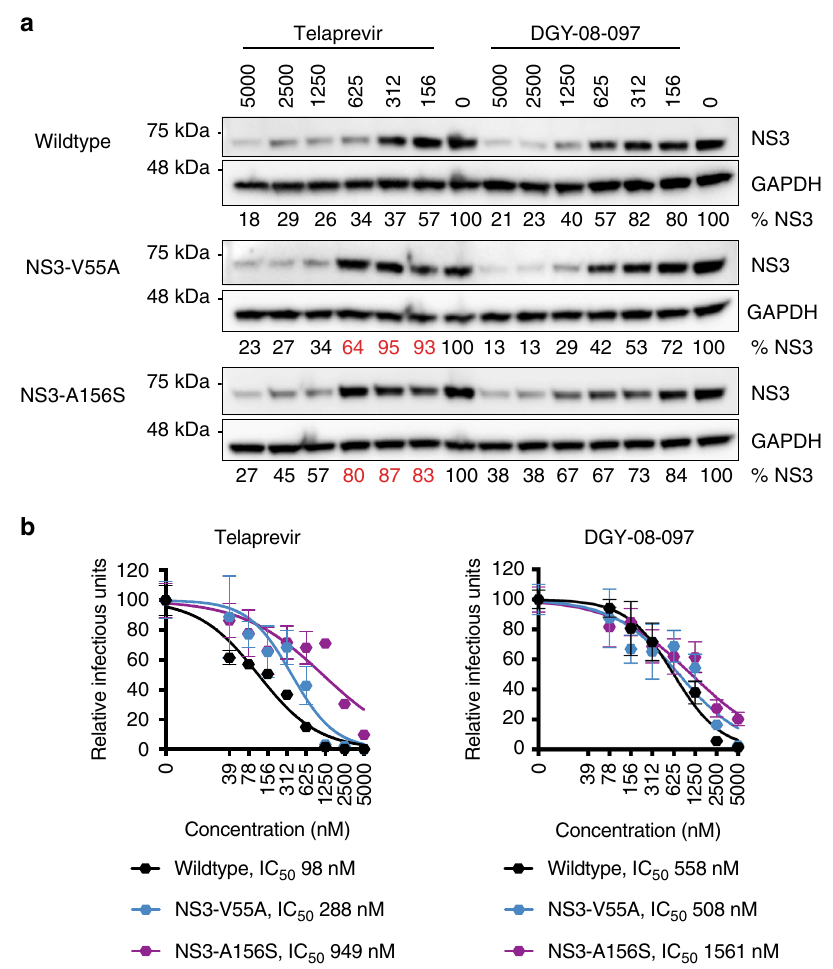
Fig. 4 The NS3 degraders inhibit telaprevir-resistant HCV. Huh7.5 cells were infected with wildtype HCV-Jc1 or the indicated telaprevir-resistant viruses at a MOI of 0.1. The infected cells were treated from 24 to 48 h post-infection with a range of small molecule concentrations (indicated in nM). a HCV NS3 and GAPDH abundance was evaluated by Western blot. Source data are provided as a Source Data fi le. One representative experiment is shown from n = 4. NS3 abundance was normalized to the loading control (GAPDH) and is presented as a percentage of the DMSO-treated control samples. Values represent the means of n = 4 independent experiments. b The amount of infectious virus released to the supernatants at 48 h post-infection was measured using a 50% tissue infectious dose (TCID 50 ) assay. The concentration of compound that led to a 50% reduction in viral titers (IC 50 ) was determined by nonlinear regression. Data are presented as means normalized to DMSO ± standard error of n = 4 technical replicates. One representative experiment is shown, with IC 50 values averaged from n ≥ 2 independent